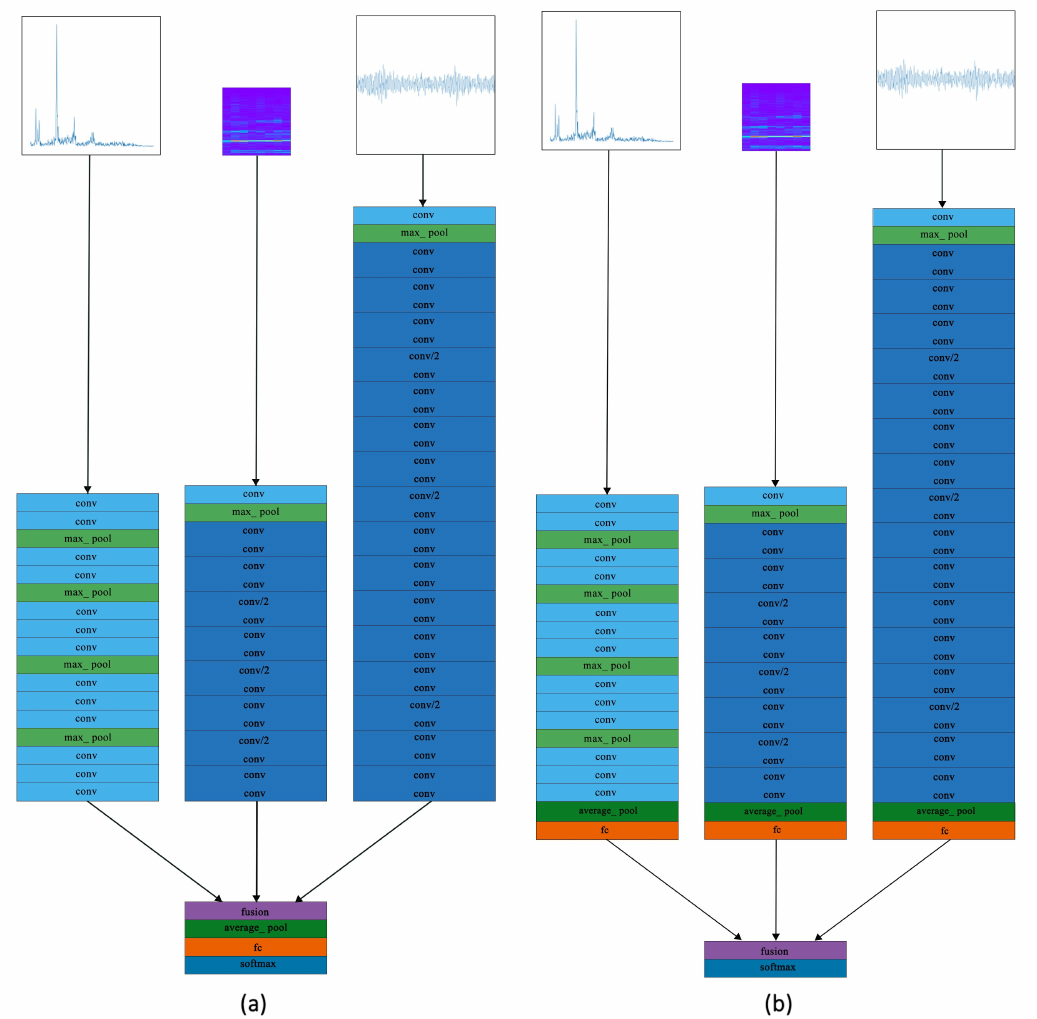
Figure 6. Two examples of multi-stream networks: ( a ) the structure fusing information after Conv and ( b ) the structure fusing information after